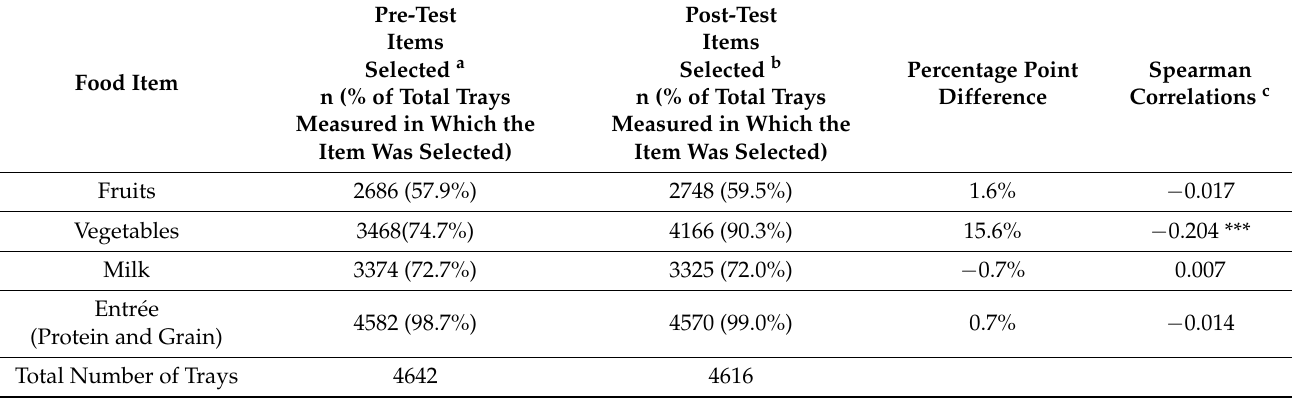
Table 1. Total Number of Items Selected by Food Component at Pre- and Post-Test Intervention ( n =